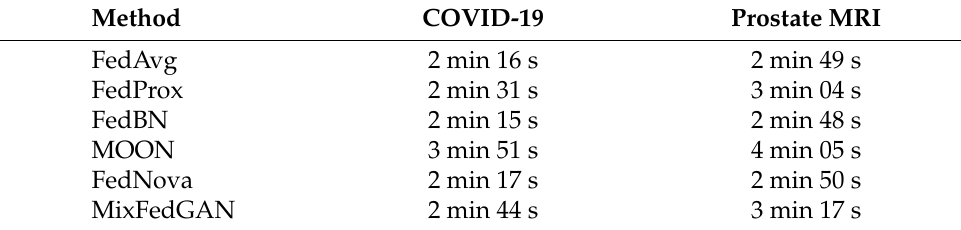
Table 4. The average training time per